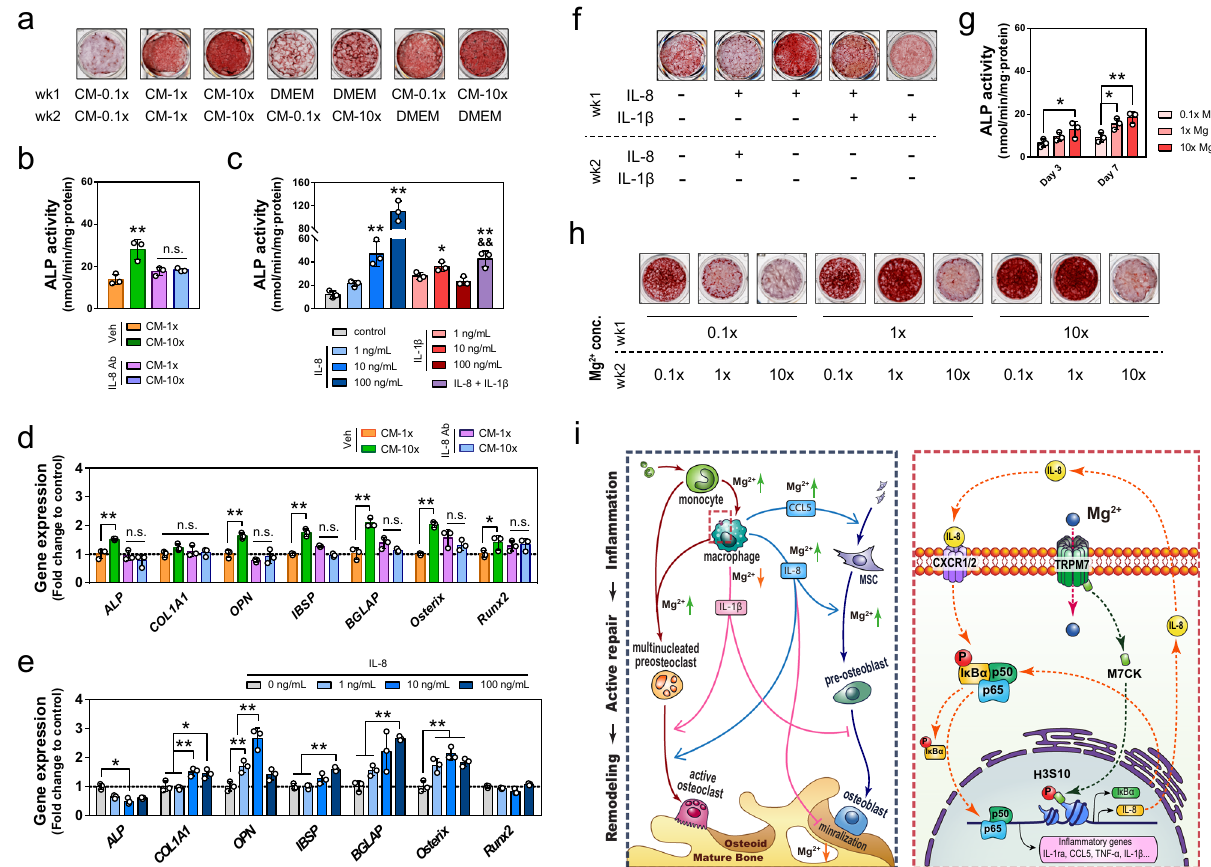
Fig. 7 The effects of Mg 2 + and its modulated in fl ammatory microenvironment on osteogenesis. a Alizarin Red staining of mineralized nodules of MSC treated with conditional medium from Mg 2 + -treated macrophages at either early or late stage of osteogenic induction. b The ALP activity of MSC cultured in conditional medium from macrophages with or without the addition of IL-8 neutralizing antibody ( n = 3). c The ALP activity of MSC cultured in medium supplemented with recombinant human IL-8 or IL-1 β ( n = 3). d The osteogenic-related gene expression of MSC cultured in conditional medium from macrophages with or without the addition of IL-8 neutralizing antibody ( n = 3). e The osteogenic-related gene expression of MSC cultured in medium supplemented with different concentrations of recombinant human IL-8 ( n = 3). f Alizarin Red staining of mineralized nodules of MSC treated with recombinant human IL-8 or IL-1 β . g The ALP activity of MSC cultured in DMEM supplemented with different concentrations of Mg 2 + ( n = 3). h Alizarin Red staining showing the mineralization of MSC treated with different concentrations of Mg 2 + at either early or late stage of osteogenic induction. i The schematic shows the mechanism in which Mg 2 + modulates both macrophages and mesenchymal stem cells in the bone healing process. Data are mean ± s.d. n.s. P > 0.05, * P < 0.05, ** P < 0.01 by one-way ANOVA with Tukey ’ s post hoc test ( b , c ) or two-way ANOVA with Tukey ’ s post hoc test ( d , e , g